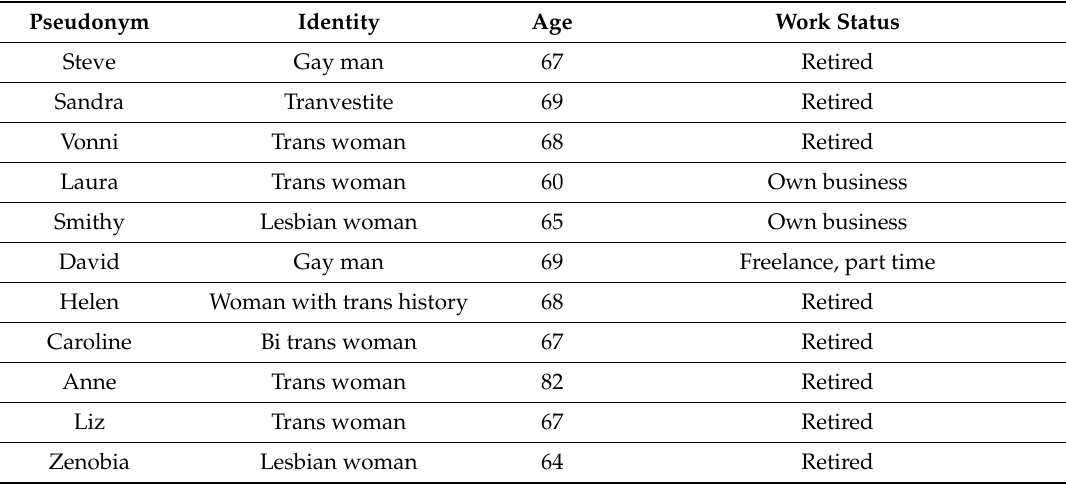
Table 2. Participant